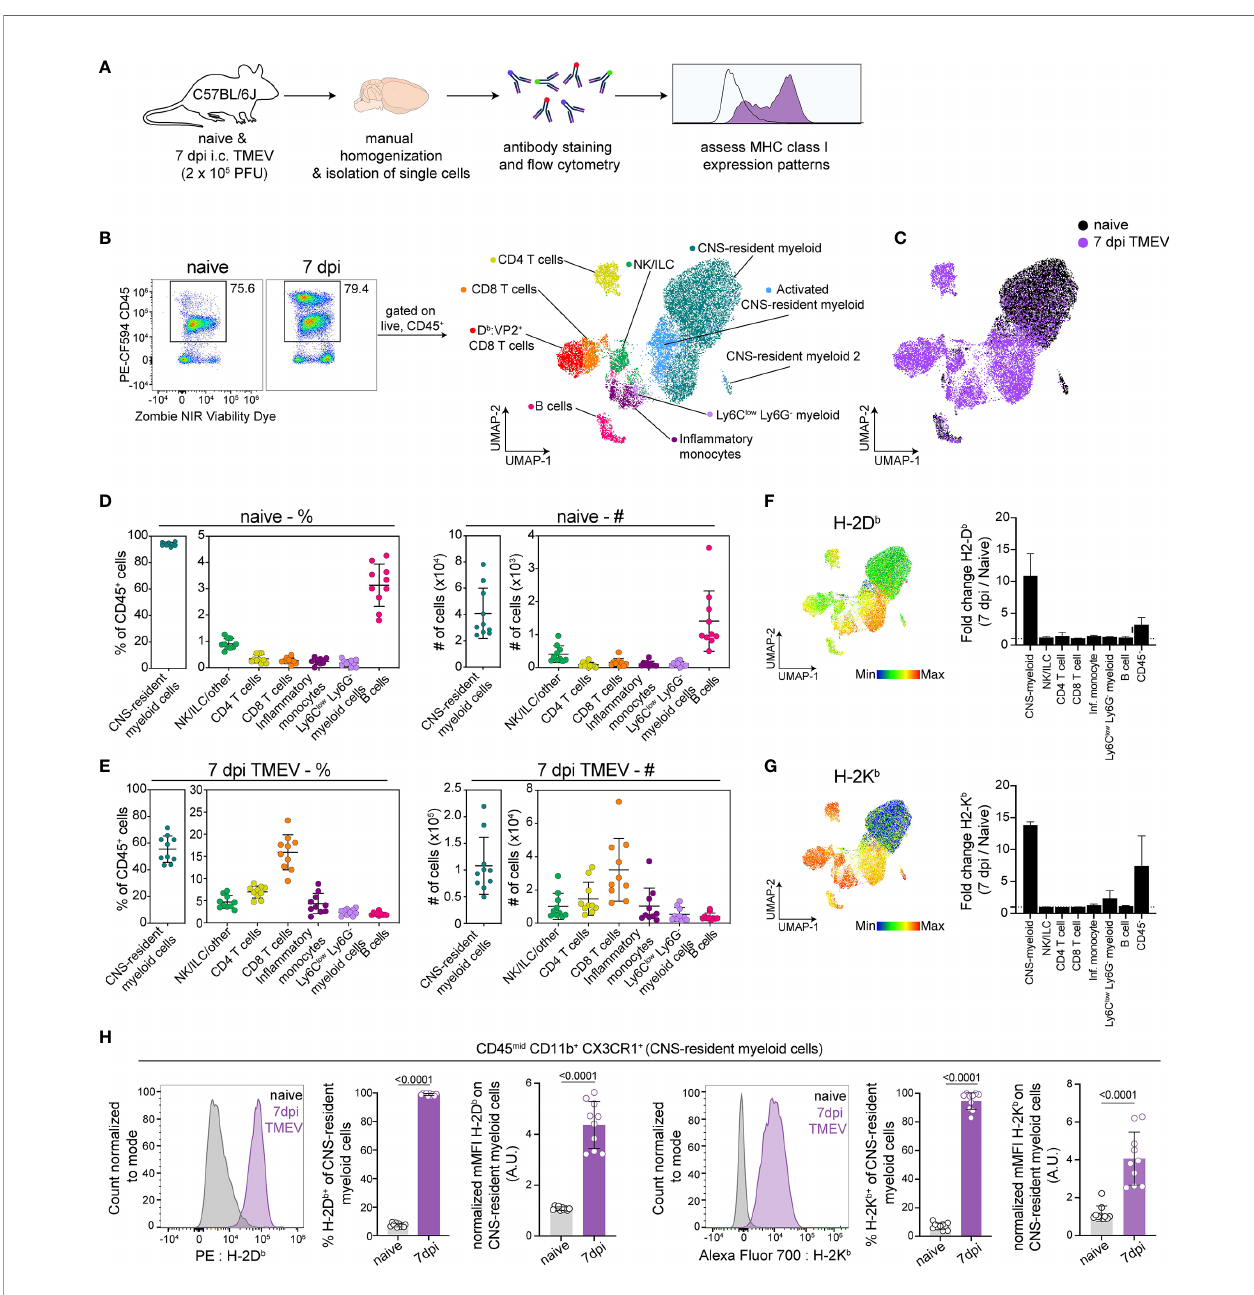
FIGURE 1 | Analysis of brain immune compartment reveals CNS-myeloid cells upregulate MHC class I in response to CNS-viral infection. (A) Experimental procedure. Brains were isolated from perfused naïve and TMEV-infected mice at 7 days post infection (dpi) (n=10), dissociated using manual homogenization, and stained with fl uorescently tagged antibodies for analysis of antigen presenting cells using high-dimensional fl ow cytometry. (B) Live CD45 + cells were downsampled and pooled for Uniform Manifold Approximation and Projection for Dimension Reduction (UMAP) analysis, identifying 7 immune cell clusters within naïve and TMEV- infected brains. (C) UMAP visualization color-coded by infection status. (D) The frequency and number of identi fi ed immune cells in the naïve brain. (E) The frequency and number of identi fi ed immune cell populations in the TMEV-infected brain at 7dpi. (F, G) UMAP visualization of CD45 + populations, colored by H-2D b expression (F) and H-2K b expression (G) , and fold change of H-2D b expression (F) and H-2K b expression (G) at 7 dpi compared to naïve in CD45 + and CD45 - cell populations. (H) CNS-myeloid cells manually gated as CD45 mid CD11b + CX3CR1 + were analyzed for H-2D b and H-2K b expression using fl ow cytometry. Representative histograms, frequency of H-2D b and H-2K b positive cells of the population, and normalized median fl uorescence intensity (MFI) of H-2D b and H-2K b on CNS-resident myeloid cells. Data are representative of ≥ 3 independent experiments and presented as mean +/- SD, 2-tailed unpaired Student ’ s t test with ns p ≥ 0.05. dpi, days post